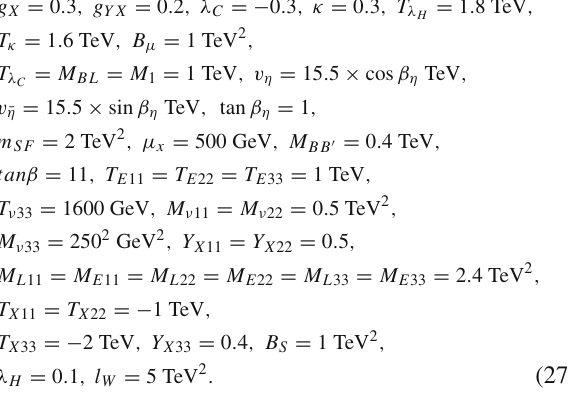
curves are around the order 5 . 0 × 10 − 10 . These